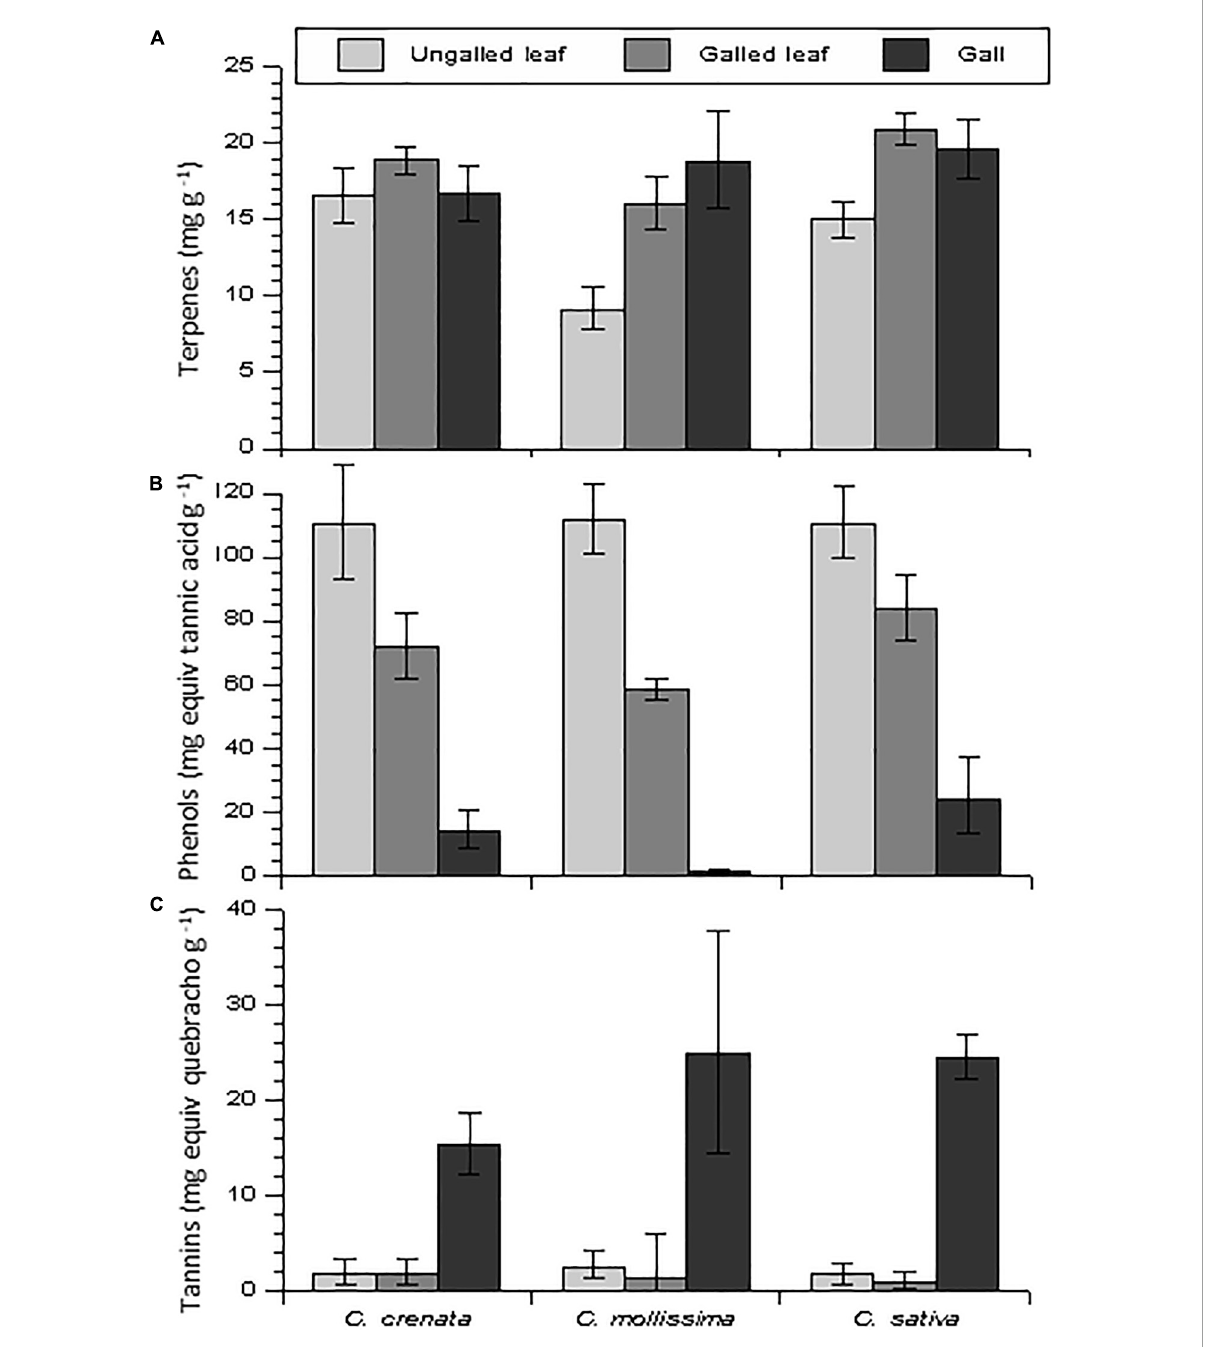
FIGURE7 Foliar concentrations of (A) terpenes, (B) phenolics, and (C) condensed tannin in galled leaves, gall tissue, and ungalled leaves of three chestnut species. Bars represent means and error bars represent standard errors.